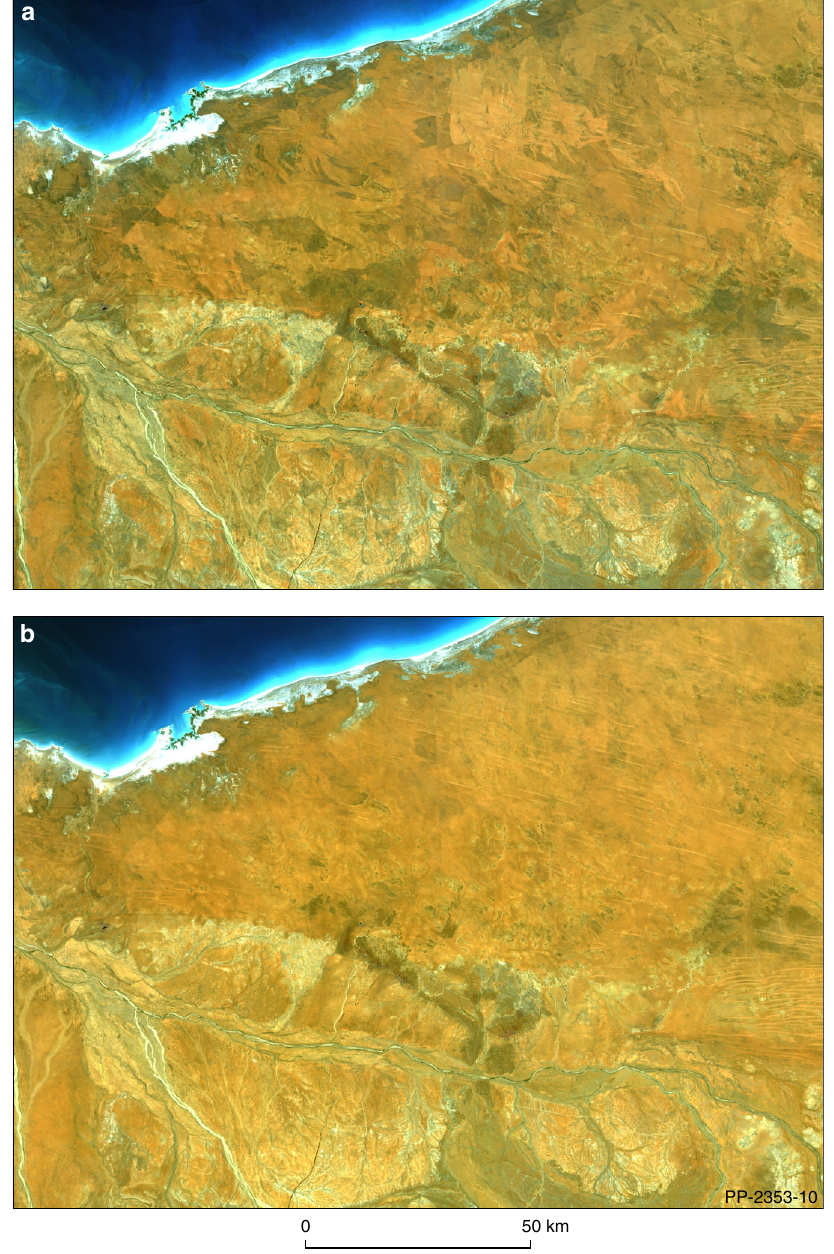
Fig. 4 Comparison between the Landsat 8 Barest Earth and the Landsat 30 + Year Barest Earth mosaic over the north-west of Australia. The second phase of our validation consisted of a continental-scale comparison between the two products that have different temporal ranges for the input data. We show both images in true colour (red 0.64 – 0.67 µ m, green 0.53 – 0.59 µ m, blue 0.45 – 0.51 µ m in the red, green, blue image channels). a Landsat 8 Barest Earth product exhibiting the vegetation patterns in the landscape (dark and light) that correlate with fi re scars of different ages and intensities. b Landsat 30 + Year Barest Earth product showing the removal of the effect of fi re